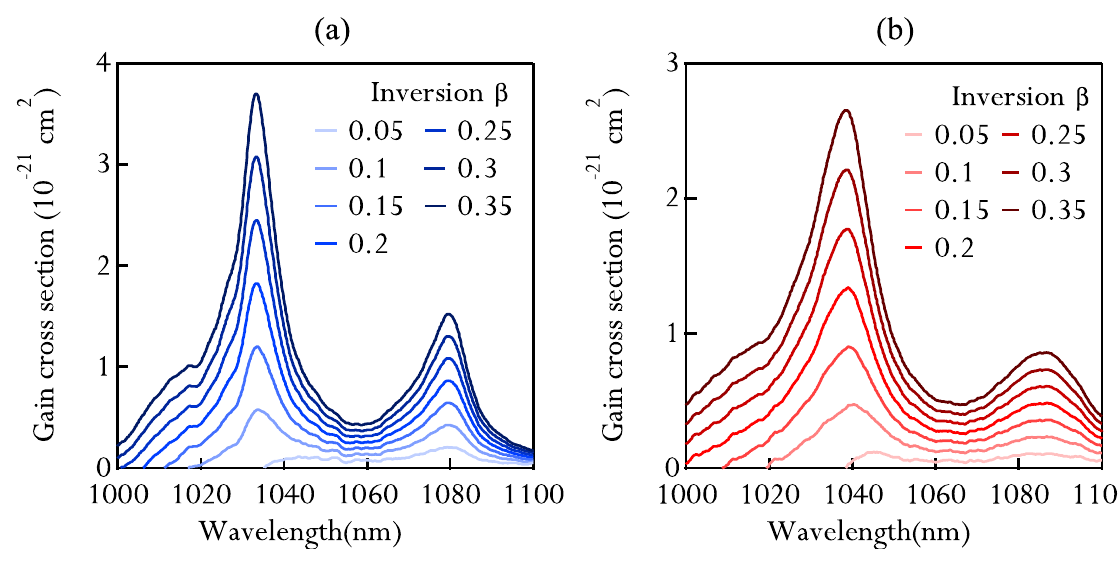
Figure 16. Left: Gain cross section of Yb:LuO for different inversion levels of the gain medium; Right: Gain cross section of Yb: LuScO for different inversion levels of the gain